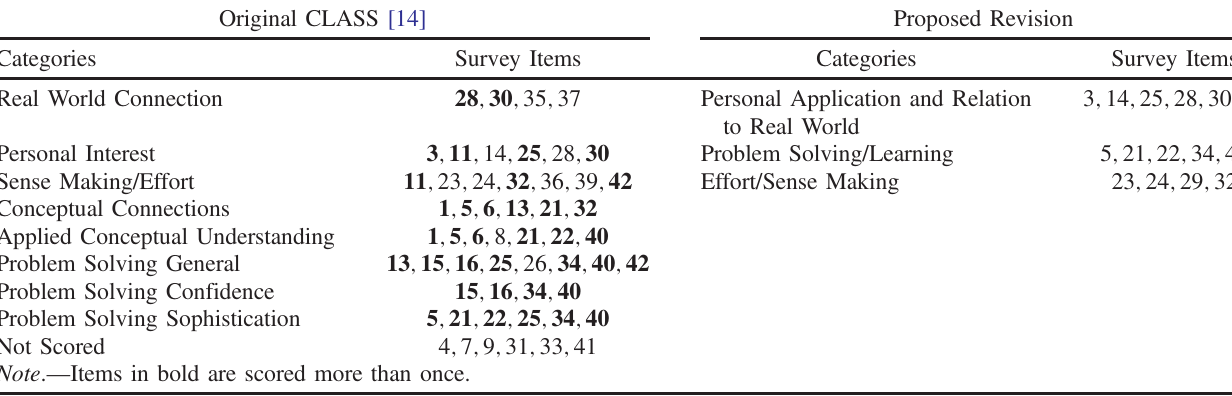
TABLE IV. The Original and Proposed Revision to the CLASS Categories and Survey